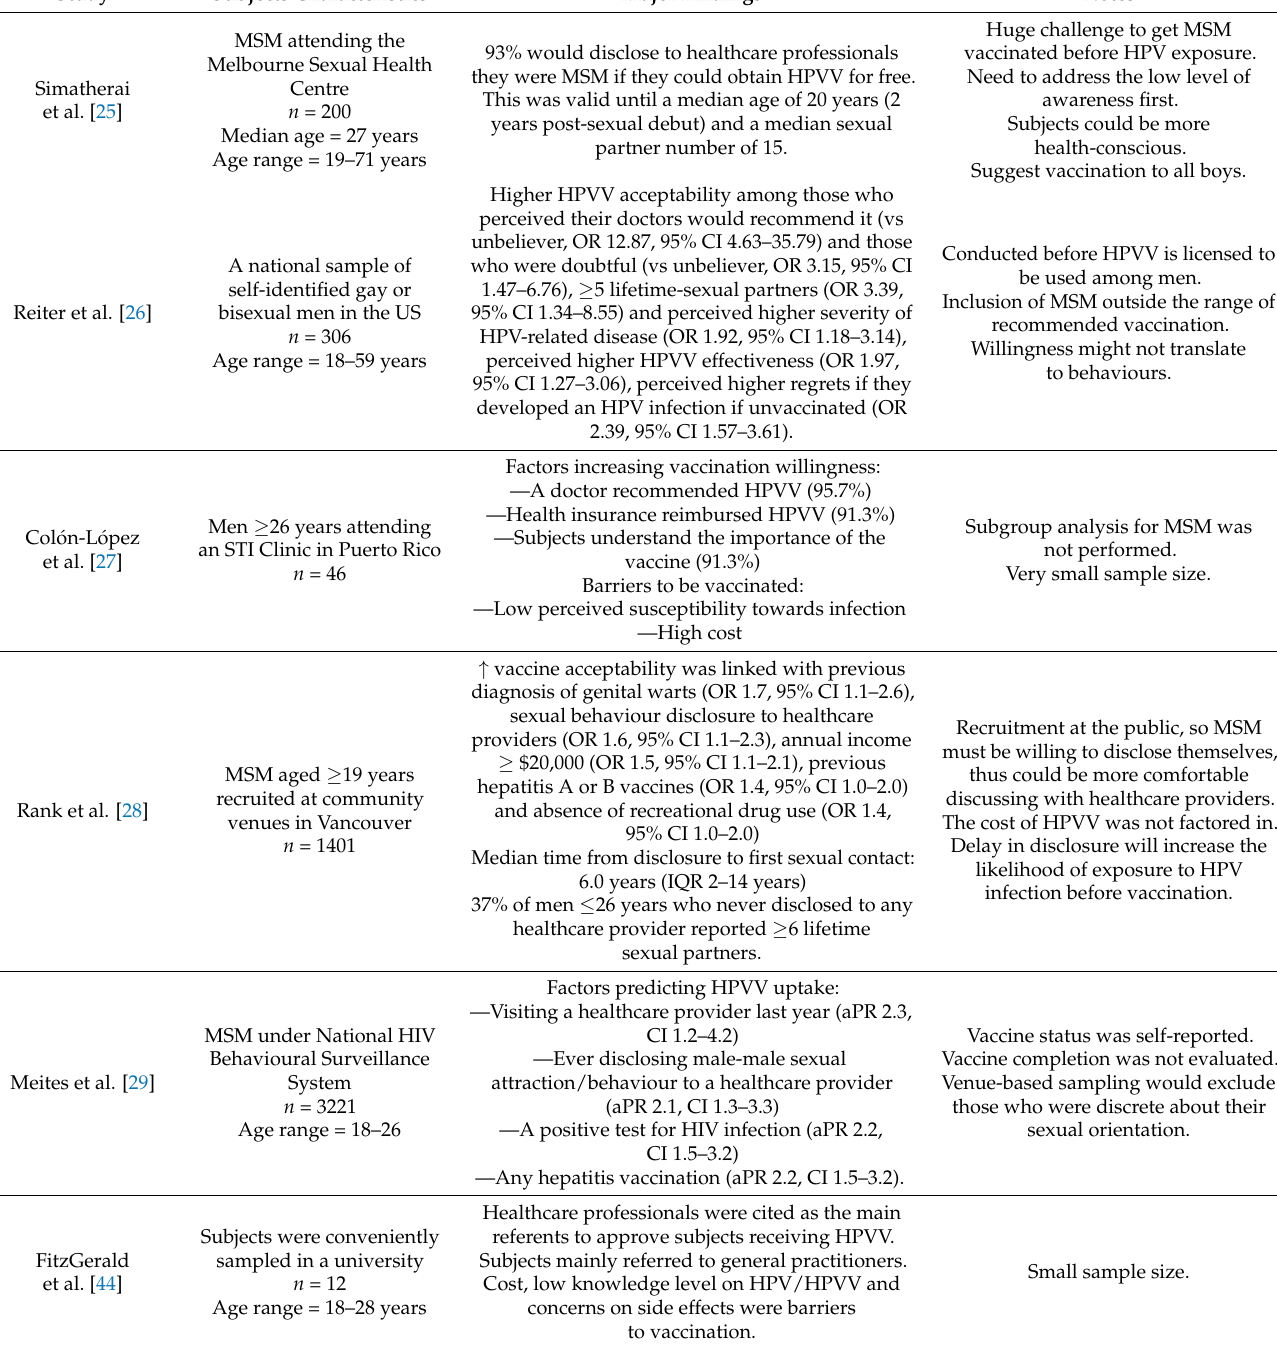
Table 1. Perceived importance of healthcare providers in promoting HPVV by